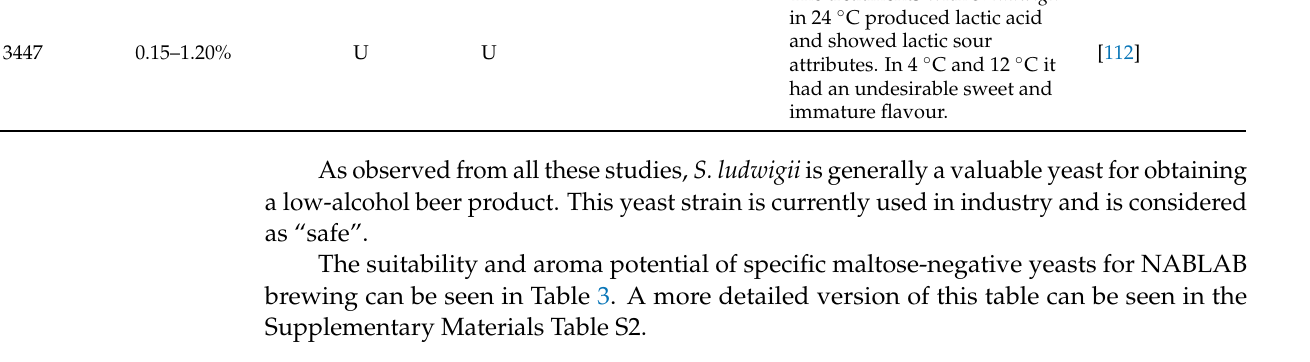
Table 3. Comparison of the suitability and aroma potential of selected maltose-negative yeast